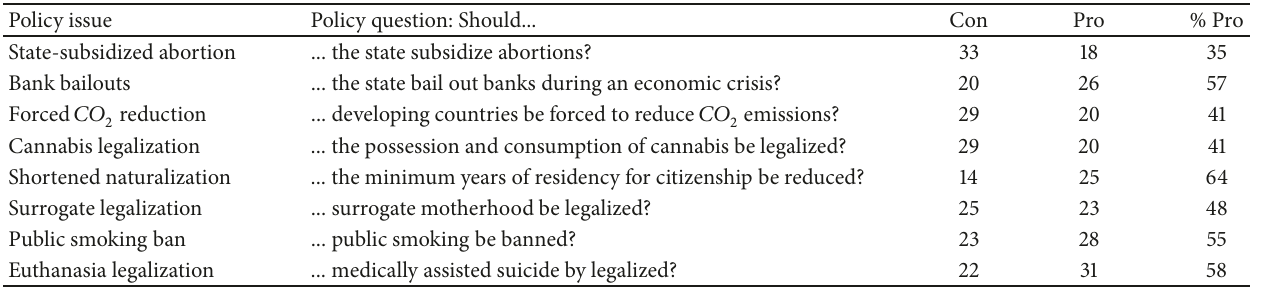
Table 1: The 8 policy issues. Con and Pro: number of participants in favor of or against the policy; % Pro: percentage of participants in favor of the policy. The issues were framed in the context of the country in which the study was conducted (Switzerland). Policy issue Policy question: Should... Con Pro %